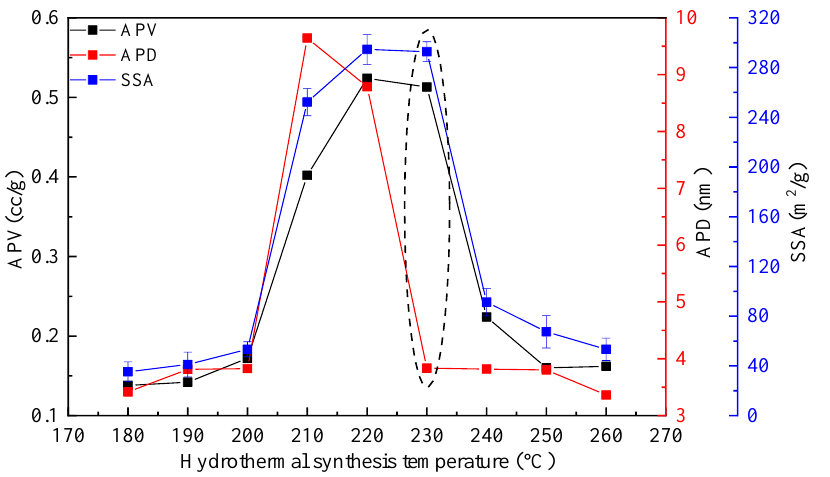
Figure 4. Change of micropore parameters for the synthesis product with increase of hydrothermal synthesis temperature.